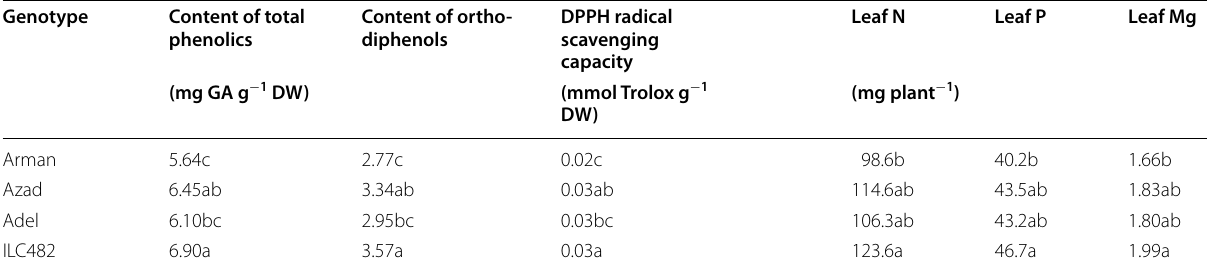
Each parameter with the same letter is not significantly different according to LSD test at the 5% level of probability